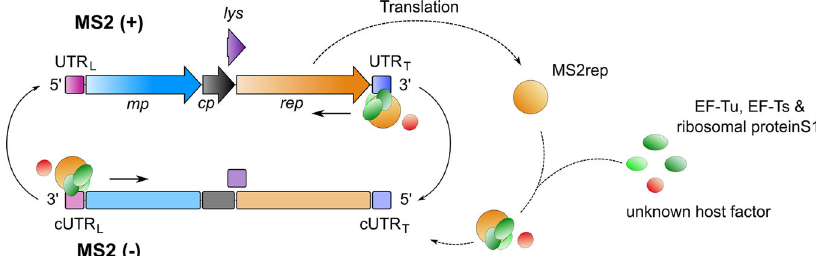
Fig. 1 Replication cycle of MS2 RNA. Scheme of replication for the ssRNA genome of MS2 bacteriophage. The 3569 nt genome encodes four proteins: the maturation protein (mp, blue) for host infection, the coat protein (cp, black) for genome encapsulation, the lysis protein (lys, purple) for cell lysis and the MS2 replicase subunit (rep, orange) for replication of the ssRNA genome. The four open reading frames on the plus strand (coloured arrows) are embedded between the leading untranslated region at the 5 ′ end (UTR L , pink) and the trailing UTR at the 3 ′ end (UTR T , dark blue). For the minus strand, the respective complementary sequences are depicted as rounded rectangles. Following translation of the MS2replicase subunit (MS2rep), formation of the holocomplex takes place. This complex is suspected to consist of host factors EF-Tu (green), EF-Ts (green), ribosomal protein S1 (green) and a putative additional host factor (red). RNA replication is initiated at the 3 ′ ends of the respective template strands, leading to the synthesis of the complementary, new template